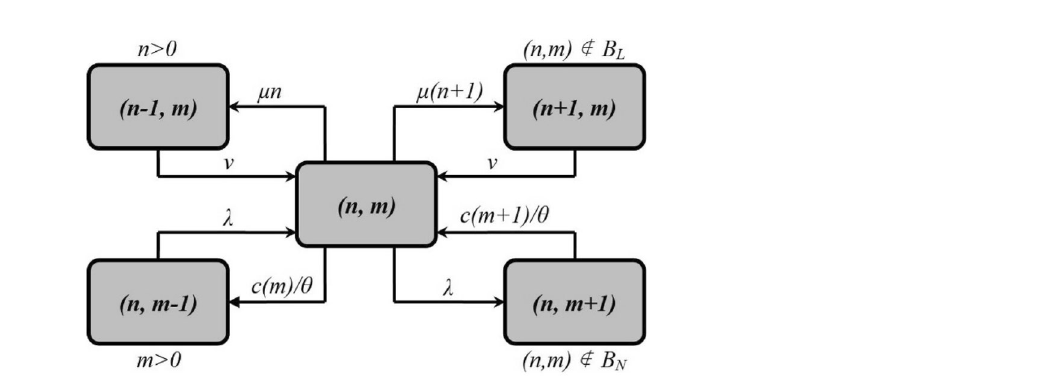
Figure 2. UML-state diagram of the investigated Markov process X